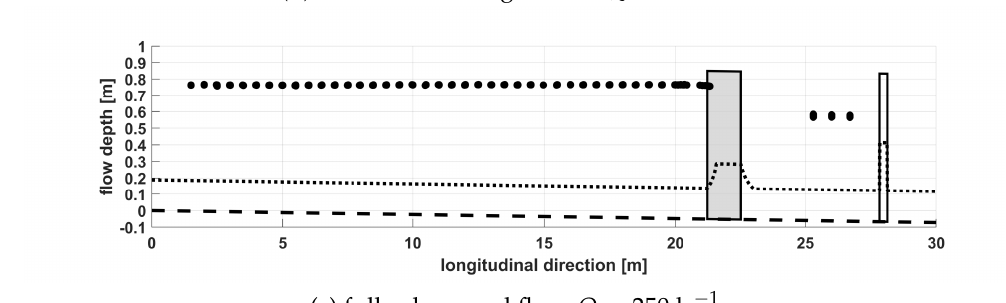
Figure 2. Exemplary profiles for the measured flow depth in longitudinal direction (x-direction) for the three investigated backwaters: ( a ) free outflow, ( b ) medium submerged flow, and ( c ) full submerged flow for an exemplary discharge each. The grey and white box marks the location of the rack and the weir, respectively. The flow direction is from left to right. The profile of the critical flow depth (dotted line) depends on the channel width of the actual cross-sections and reveals the predominant flow regime (supercritical flow: h < h crit , subcritical flow: h > h crit